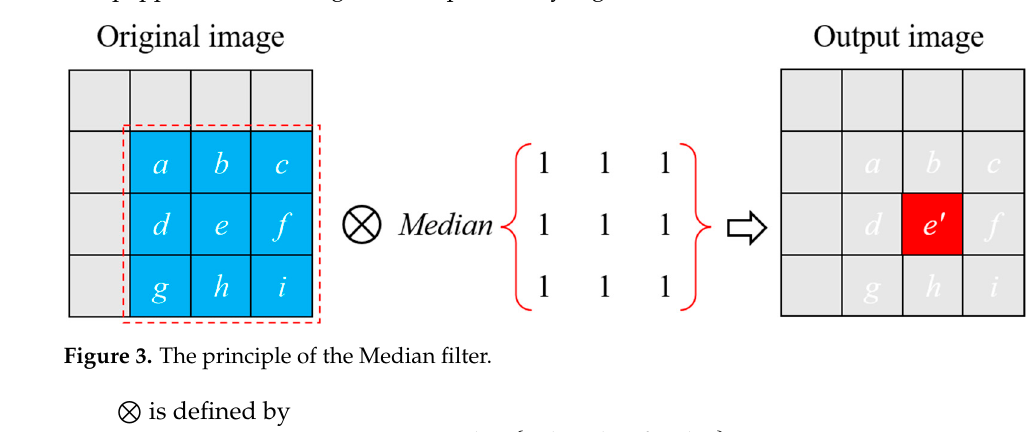
Figure 2. The description of dilation and erosion operations. ( a ) original image; ( b ) the structuring element; ( c ) the processing result of dilation operation; ( d ) the processing result of erosion operation. The Median filter is one of Sequential statistical filters, which can replace the target pixel value with the median gray value of its neighborhood. It is applied to reduce the salt and pepper noise of images and explained by Figure 3.